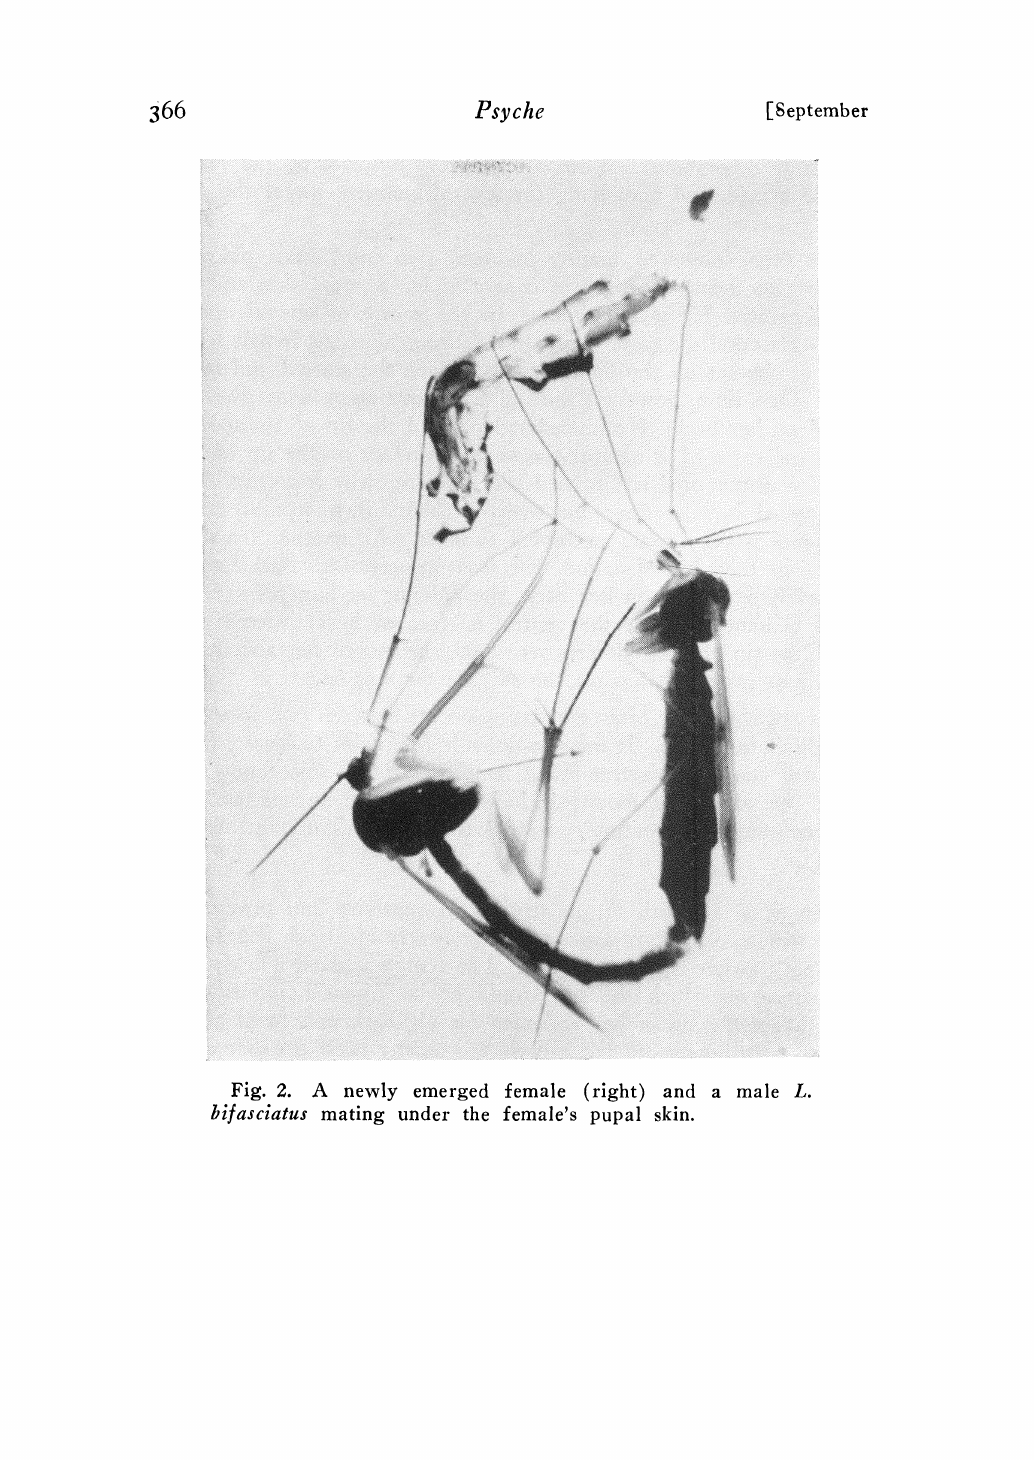
Fig. 2. A newly emerged female (right) and a male L. bi]asciatus mating under the female’s pupal